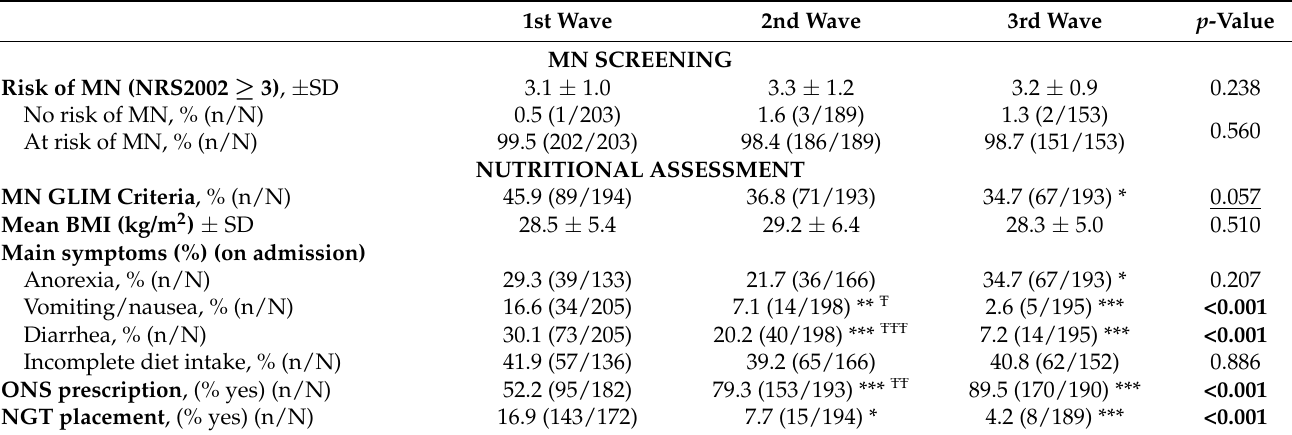
Bold indicates statistically significant. Dep. indicates dependence. Clinical characteristics and the therapeutic approach of the three waves of COVID-19 patients is described in Table 2. The main differences between waves show a higher need for high-flux Venturi masks in the first and second waves ( p < 0.001). The mean peak FIO2 administered in the second and third waves was significantly higher than in the first, although the ratio between oxygen arterial pressure (PaO2) and the FIO2 (PAFI) was greater in the first wave. The percentage of patients admitted to the ICU was higher in the first wave ( p < 0.05) with a higher rate of orotracheal intubation ( p = 0.009) than in the second wave, where an increase in the use of nasal intermittent positive pressure ventilation was observed ( p < 0.05). Patients in the first wave had longer hospital stay ( p < 0.001). Intra-hospital mortality was high among the three waves, especially in the third one (19.1%; p < 0.05 vs. 1st wave).